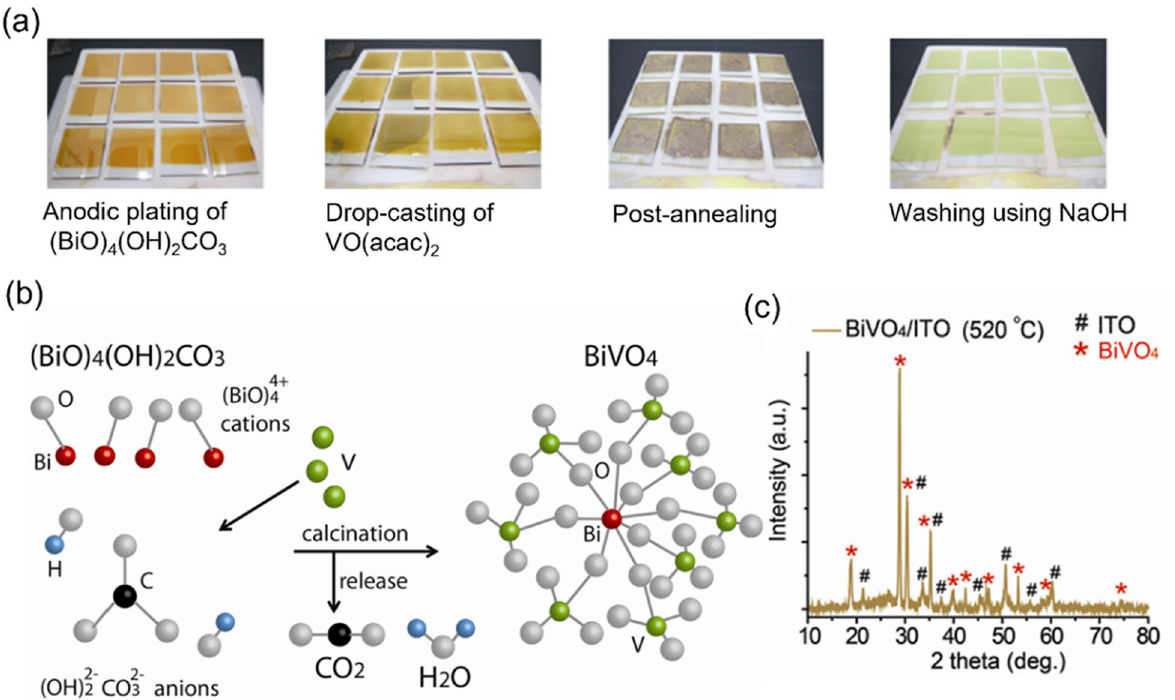
Fig. 3 a Optical images of the solution-based process for the synthesis of BiVO Schematic diagram of a proposed reaction mechanism. c XRD patterns of the BiVO